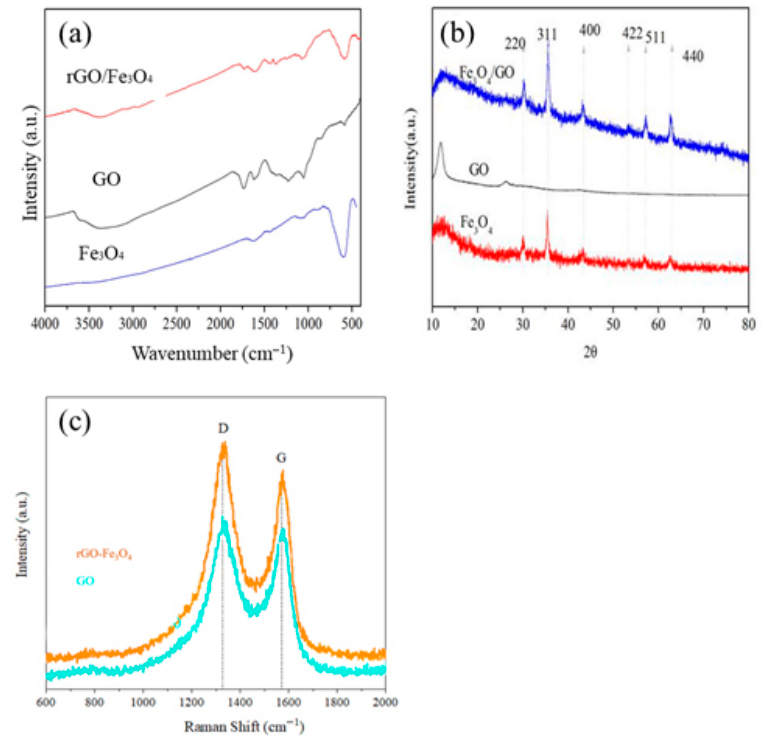
Figure 3. ( a ) FTIR spectra of GO, Fe 3 O 4 and rGO/Fe 3 O 4 ; ( b ) XRD patterns of GO, Fe 3 O 4 and rGO/Fe 3 O 4 ; ( c ) Raman spectra of GO and rGO/Fe 3 O 4 . rGO/Fe 3 O 4 ; ( c ) Raman spectra of GO and rGO/Fe 3 O 4